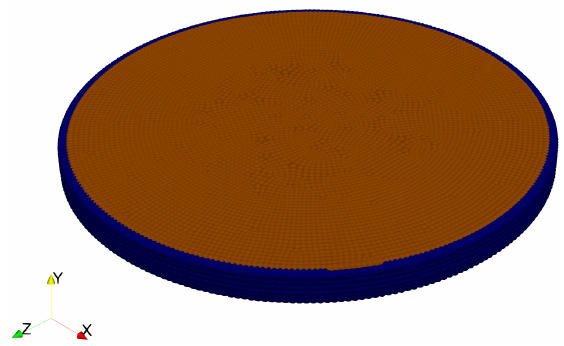
Figure 6. Disc soil model for two-dimensional desiccation cracking